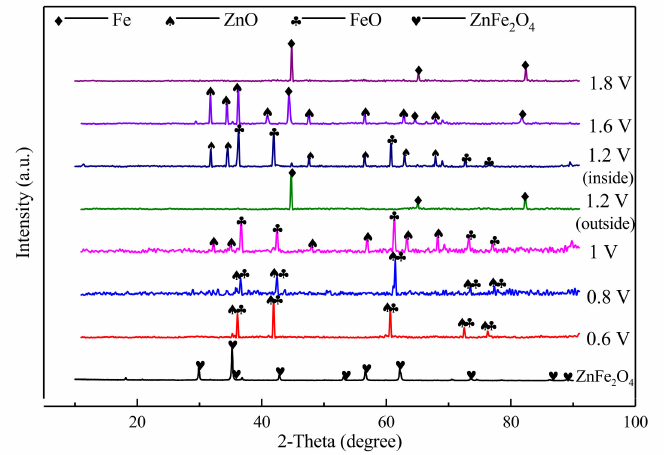
Figure 8. XRD of products at different electrolysis voltages ( E = 0.6 V~1.8 V, T = 800 ◦ C, t = 8 h).